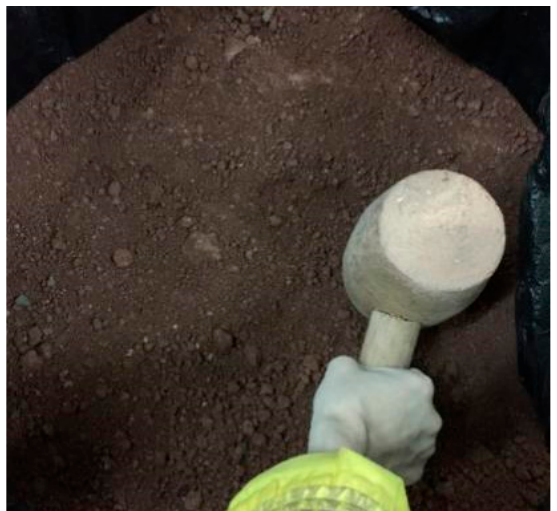
Figure 6. Tap and compact.